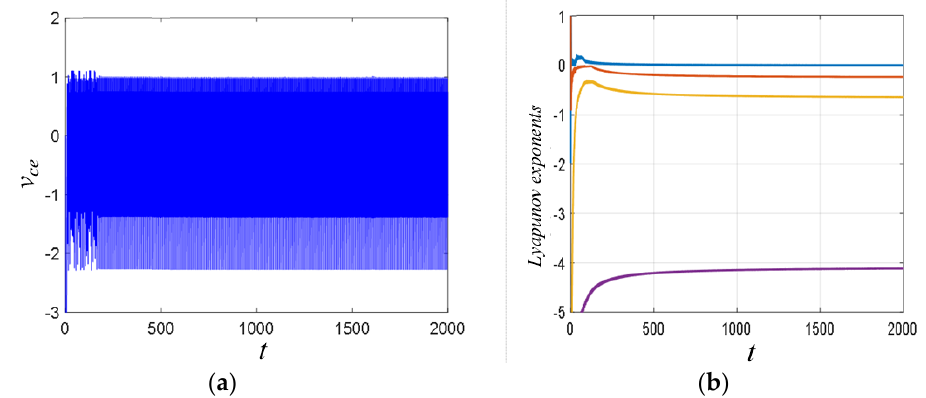
11 of 17 Figure 11. Diagram of maximal Lyapunov exponents with different initial condition: ( a ) [0.1 0 − 1 0.1] ( b ) [0.1 0 1.68 0.1]. 4.4. Intermittent Chaos and Transient Chaos The irregular alternation of periodic and chaotic is known as intermittency, which is caused by an interior crisis. The time-domain waveform of state variable v ce is shown in Figure 12. Figure 12b is the enlargement of Figure 12a; it can be seen that it alternates between chaotic orbits and periodic orbits. Figure 12. Time-domain waveform of v ce when R = 228.6 and the initial conditions are [0.1, 0, − 1, 0.1]: ( a ) t ∈ [0, 10,000], ( b ) t ∈ [200, 800].